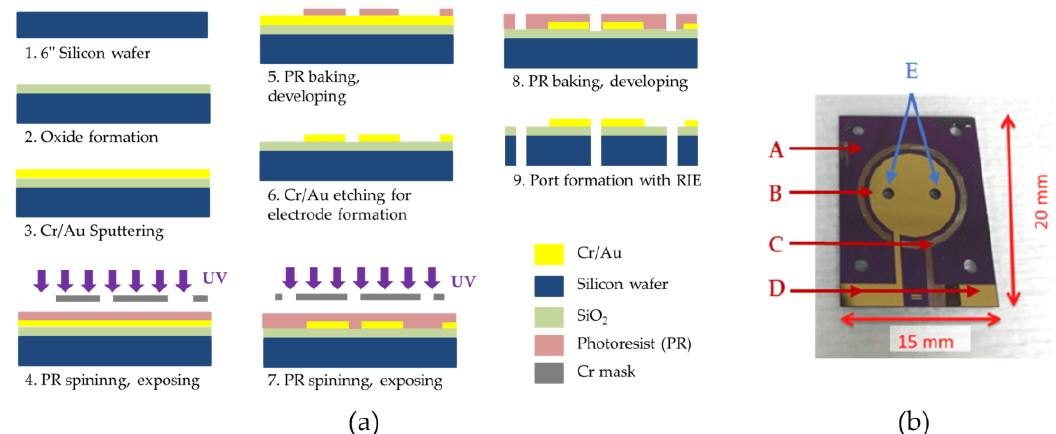
Figure 2. ( a ) Micro-scale Microbial Fuel Cell (MFC) (µMFC) electrode microfabrication steps; ( b ) microfabricated µMFC electrode. When two electrodes on substrates faced each other at 180°, the gold contact pads were exposed for electrical wiring. A: Silicon substrate; B: gold electrode; C: silver electrode (the brownish thin circular electrode around the gold electrode is the oxidized silver layer to be processed as the reference electrode for further studies); D: contact pads for electrical connection; and E: inlet and outlet ports.